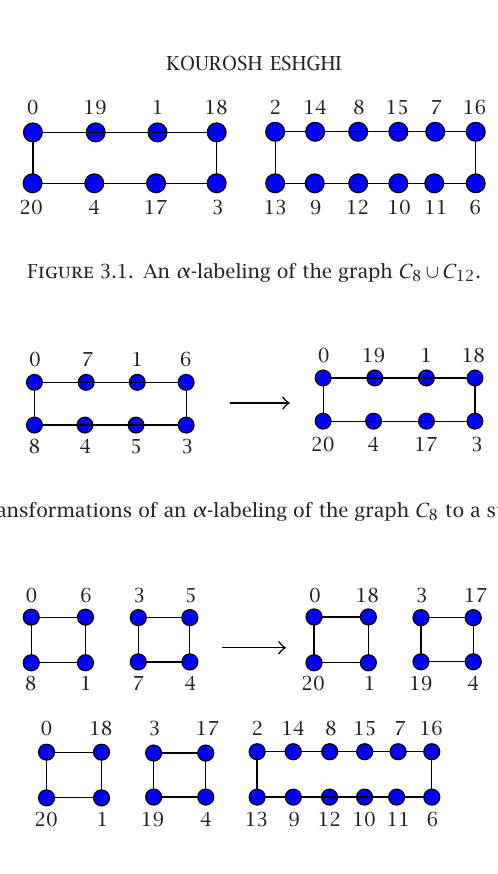
Figure 3.3 . An α -labeling of C